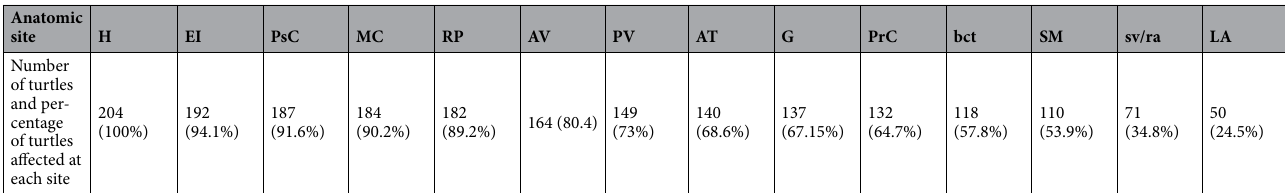
Table 2. Anatomic sites of gas distribution as seen radiographically in 204 loggerhead turtles affected by GE. H hepatic vessels, EI external iliac vessels, PsC. postcaval vein, MC margino-costal vessels, RP renal portal vessels, AV abdominal vein, PV pulmonary vessels, AT transverse abdominal vein, G gastric vessels, PrC . precaval vein, bct brachiocephalic trunk, SM superior mesenteric artery, sv/ra sinus venosus/right atrium, LA left atrium.